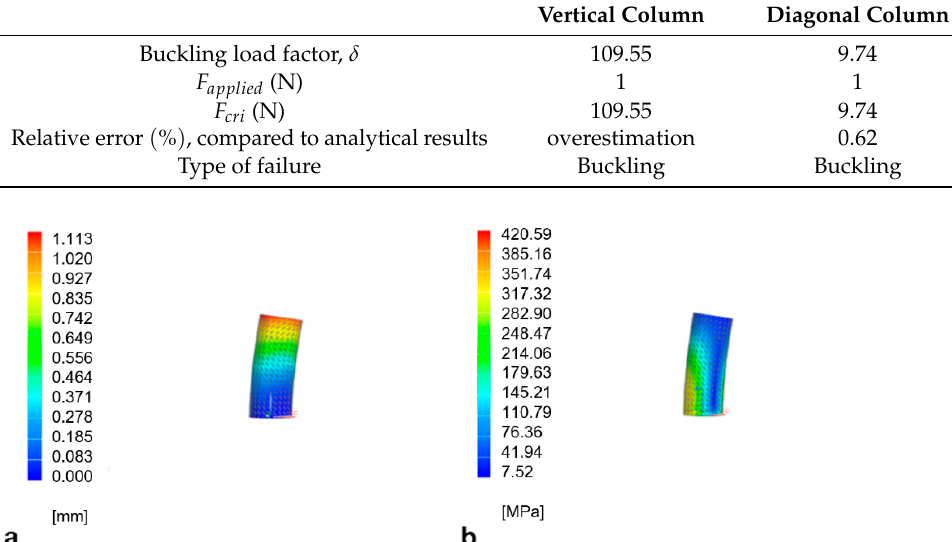
Table 2. Numerical buckling results for both column components. Table 3. The various Young’s moduli used in the MFA composite bridge bearing model.